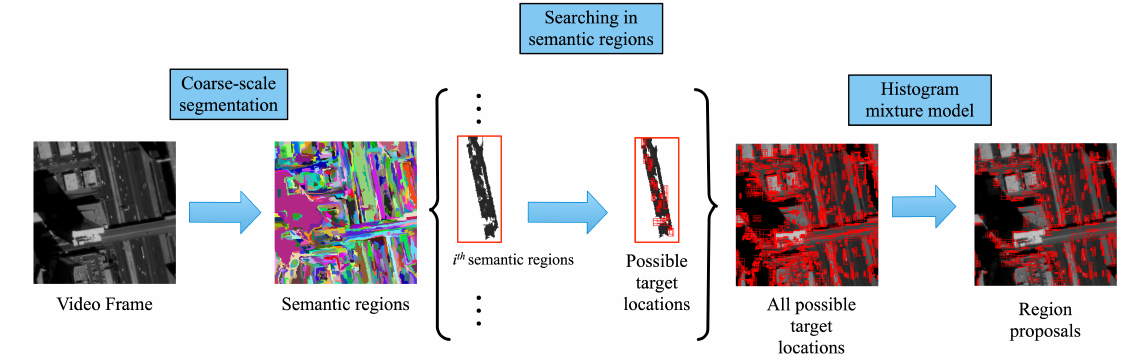
Figure 1. Overview of the proposed region proposal